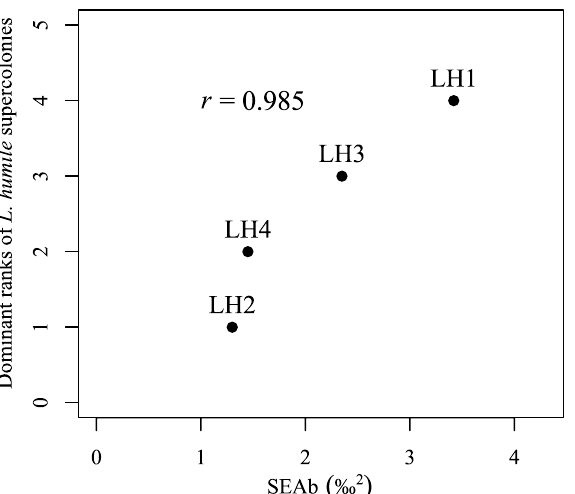
Figure 7. Relationship between the SEAb [10 5 Bayesian iterations of SEAc (unbiased correction for differences in sample size of SEA)] values of the four supercolonies of Linepithema humile established in Kobe, Hyogo, Japan, and their dominance ranks in their introduced ranges. Dominance ranks were calculated using the number of introduced countries and regions in the world (see Inoue et al. 18 for details on the distribution range of each L. humile